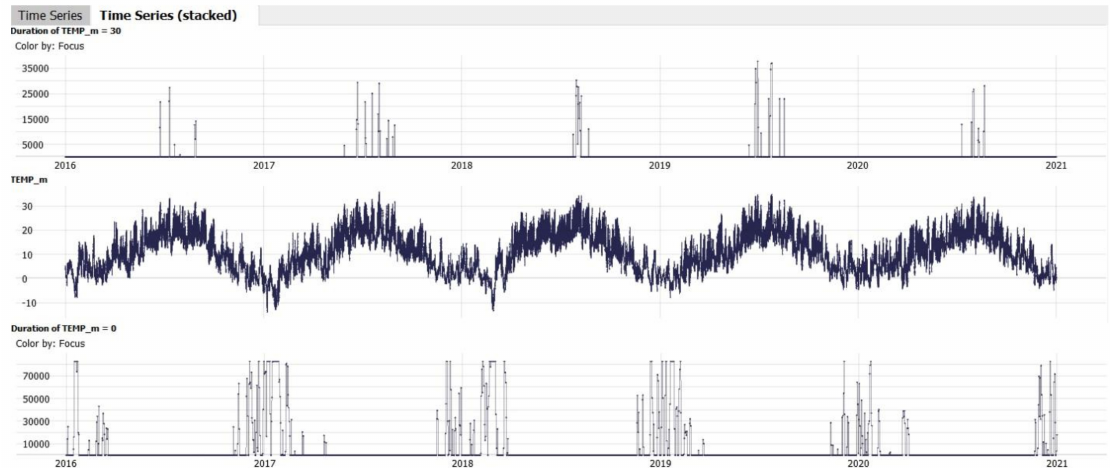
Figure 6. Annual distribution and diurnal duration (expressed in seconds) of temperature breaching a predefined threshold for Munich: temperature maxima ( above ), temperature minima ( below ).